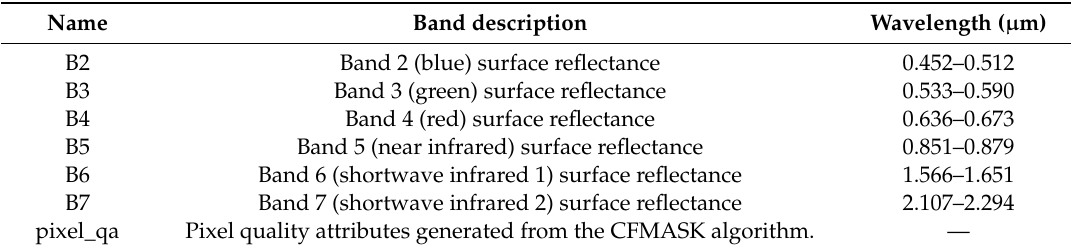
Table 1. Landsat 8 band description and wavelengths. The “pixel_qa” band provides metadata on scene quality such as cloud cover for each